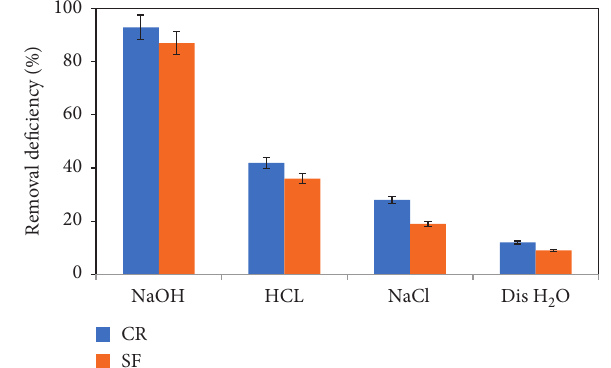
Figure 10: Desorption studies of CR and SF dyes adsorbed on APC adsorbent.